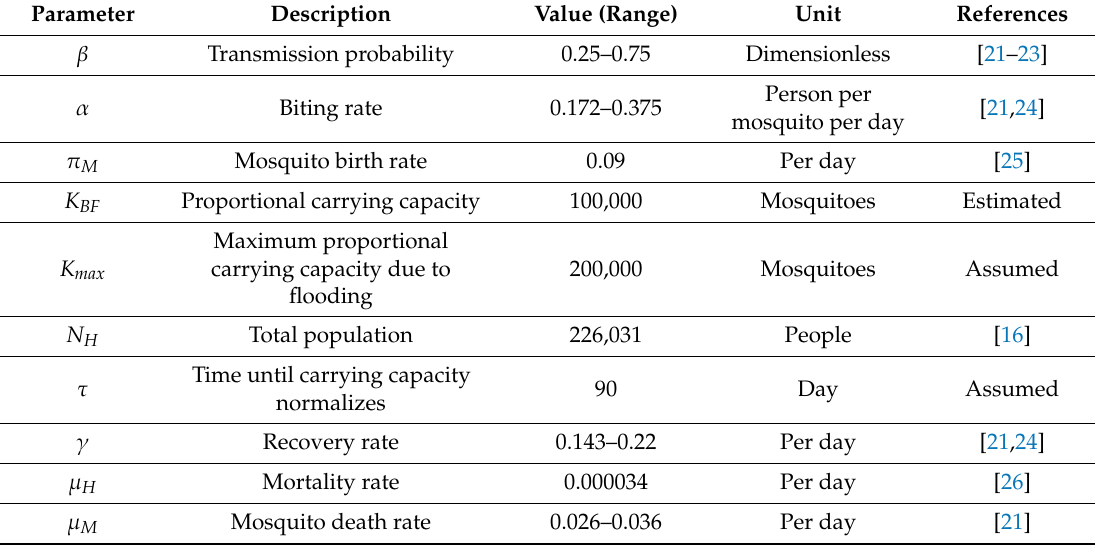
Table 1. Parameter descriptions and values for model Equations (6) and